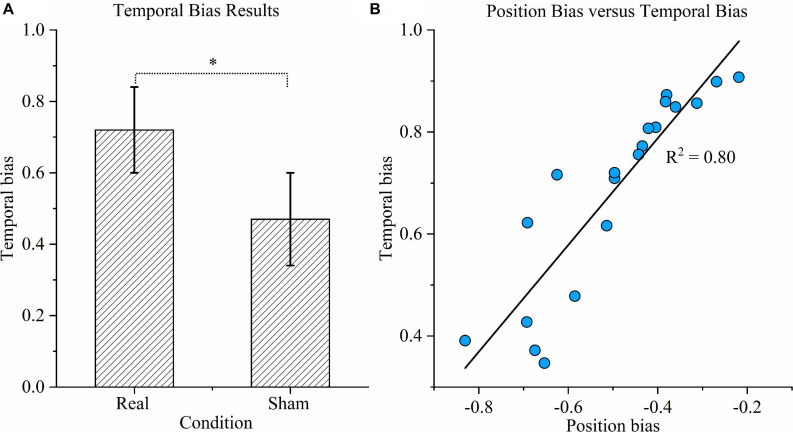
Time task results. (A) Temporal bias results. Temporal bias was defined as the proportion of participants indicating that the duration of the right rotation was longer when the rotations in opposite directions were in fact equal. Asterisks indicate significant differences between real and sham transcranial direct current stimulation (tDCS) conditions (P < 0.01). (B) Correlation between position bias and temporal bias. Correlation between position bias in position task performance and temporal bias in time task performance across all participants under the real tDCS condition. The coefficient of determination denoted R2 in the figure is the proportion of temporal bias that can be predicted from position bias.